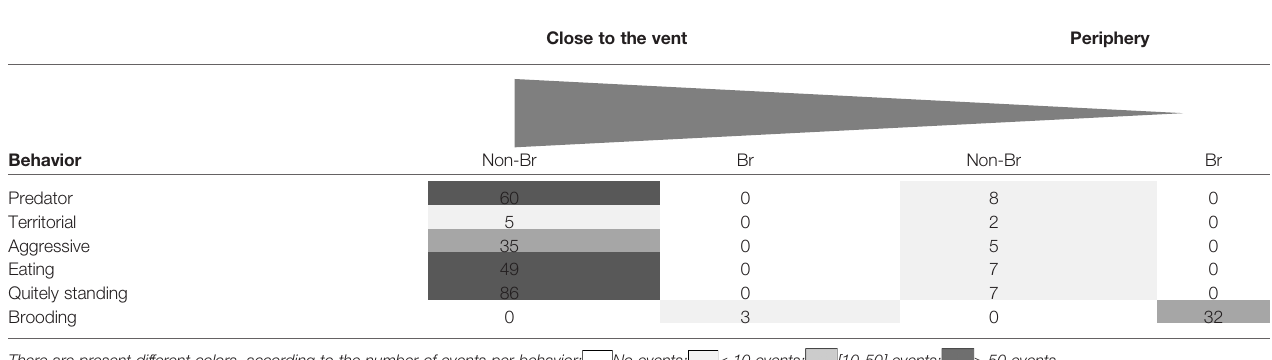
TABLE 1 | Behavior of non-brooding (Non-Br) and brooding (Br) crabs of Segonzacia mesatlantica close to the vent and at the vent periphery, including predator, territorial, aggressive, eating, quietly standing, and brooding